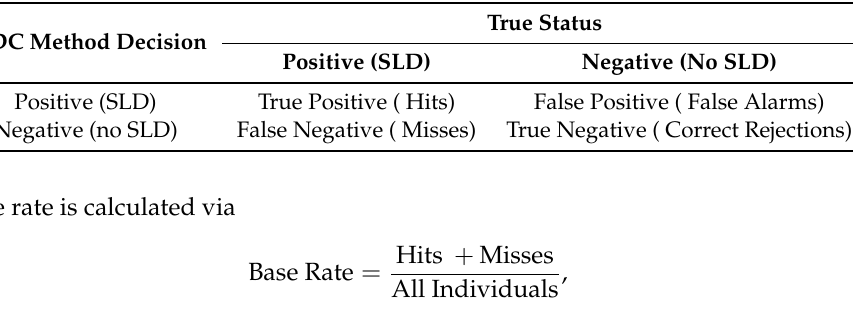
Table A1. Example of a classification table needed for utility